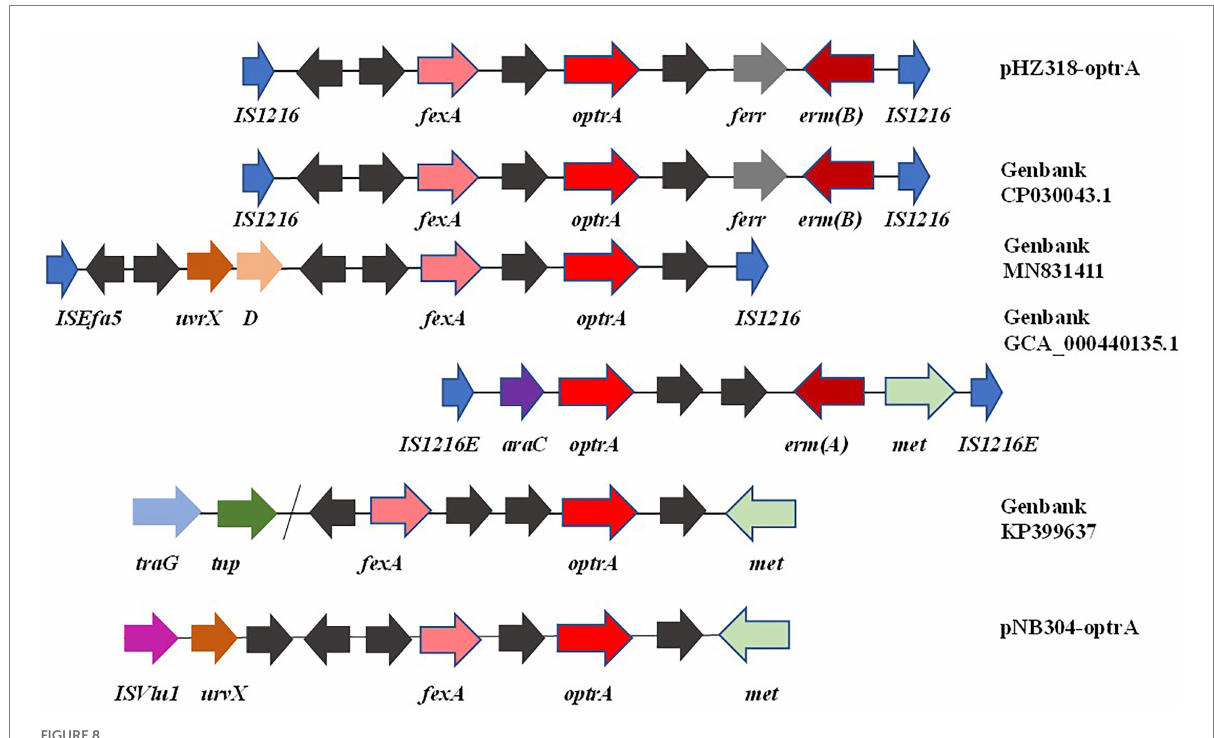
FIGURE 8 Diversity of flanking genetic environment of optrA gene on plasmids.